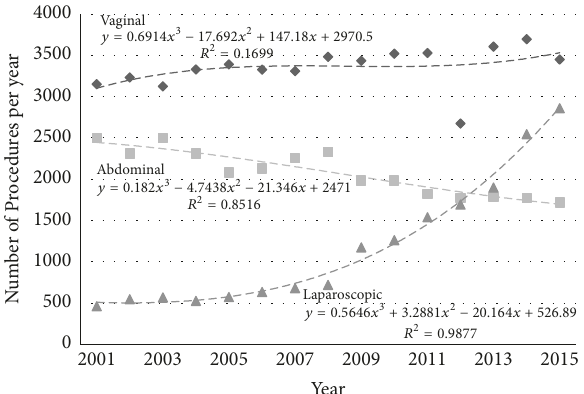
Figure 3: Absolute number of hysterectomies by different routes ( X vaginal, ◼ abdominal, and 󳵳 laparoscopic) in Australia in women aged 55–74 years.